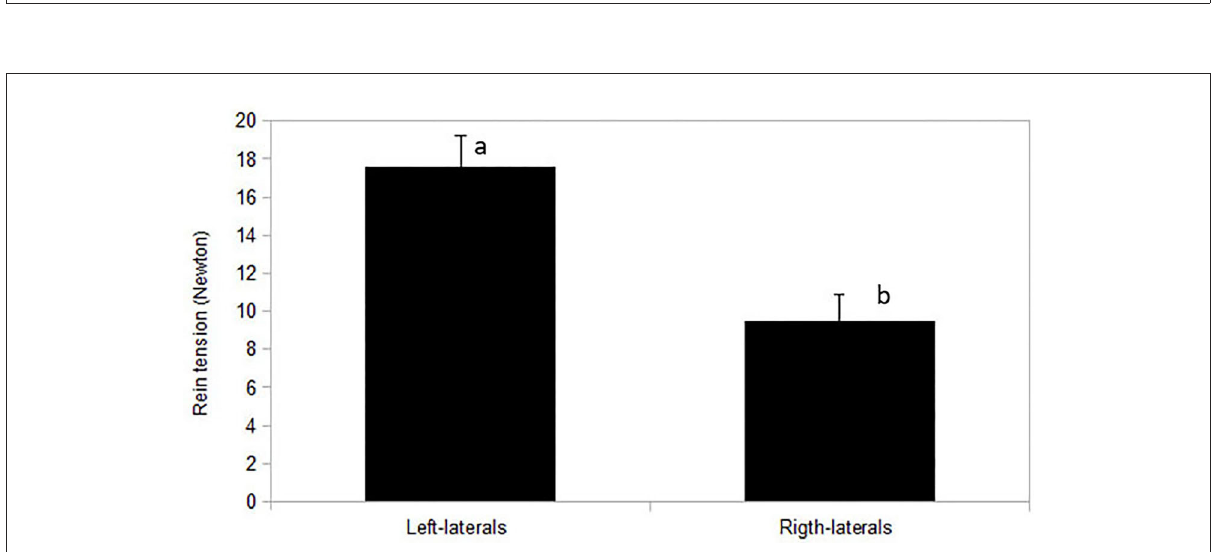
FIGURE6 Mean rein tension (N) of both reins overall during riding of a standardized dressage task in relation to horse’s laterality (right-lateral n = 10, left-lateral n = 2) assessed by the riders. Mean of both reins was higher in left-lateral horses ( p = 0.02). Different letters indicate a significant difference at p < 0.05.